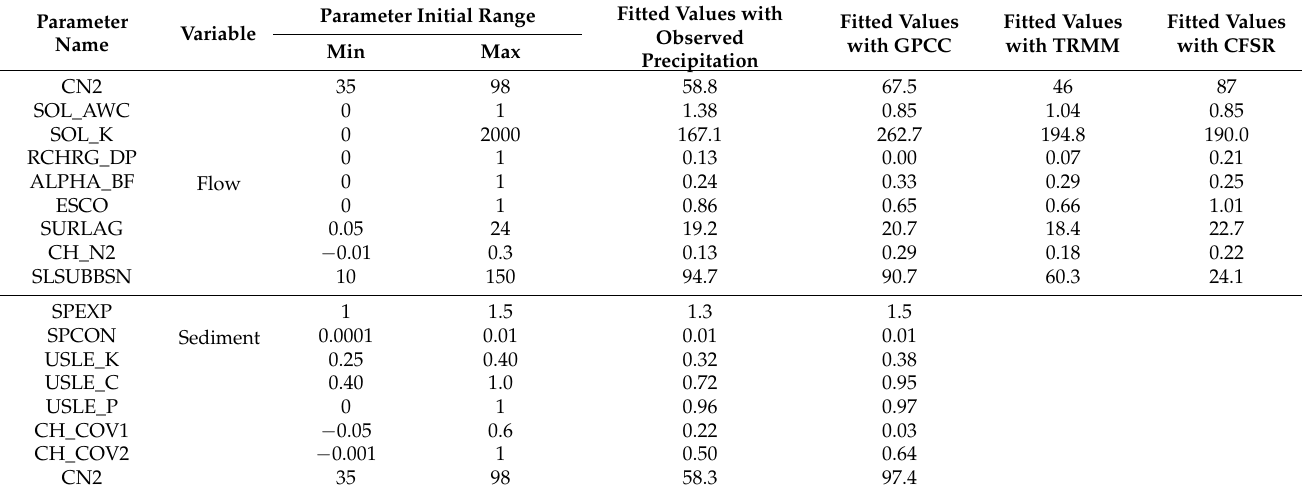
Table 5. List of the selected parameters and their